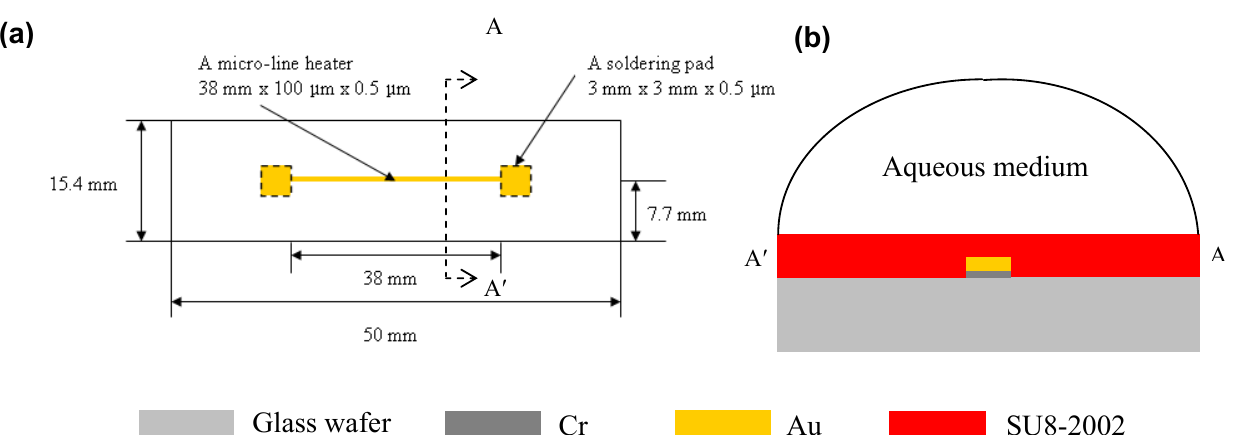
Figure 2. (a) A micro-line heater design. (b) Schematic illustration of the microscale thermal environment with a